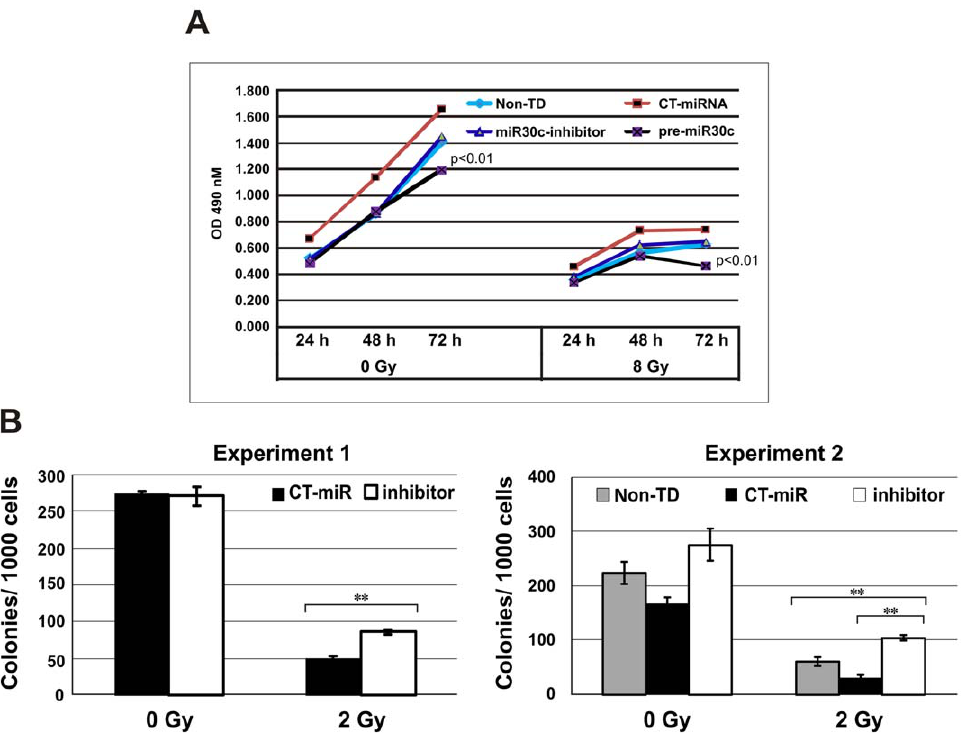
Figure 6. Effects of miR-30c on radiation injury of hFOB and CD34 + cells. (A) Cell death and proliferation potential were measured using the CellTiter 96R AQueous non-radioactive cell proliferation assay (MTS-assay). The quantity of formazan product as measured by the amount of 490 nm absorbance (OD) is directly proportional to the number of living cells in culture. Levels of OD were dramatically lower in pre-miR30-transfected hFOB cells in both irradiated and non-irradiated samples, compared with controls and miR30 inhibitor-transfected samples (p , 0.01). Representative expression from 3 independent experiments is shown. (B) Clonogenicity of human hematopoietic progenitor CD34 + cells was quantified in standard semisolid cultures in triplicate. Colonies were counted 14 days later. Results from two experiments showed that transfection of miR30 inhibitor resulted in significant colony number increases in irradiated cells. Means 6 SD. **, p , 0.01, miR30c inhibitor vs. controls. Non-TD: miRNA- untransfected